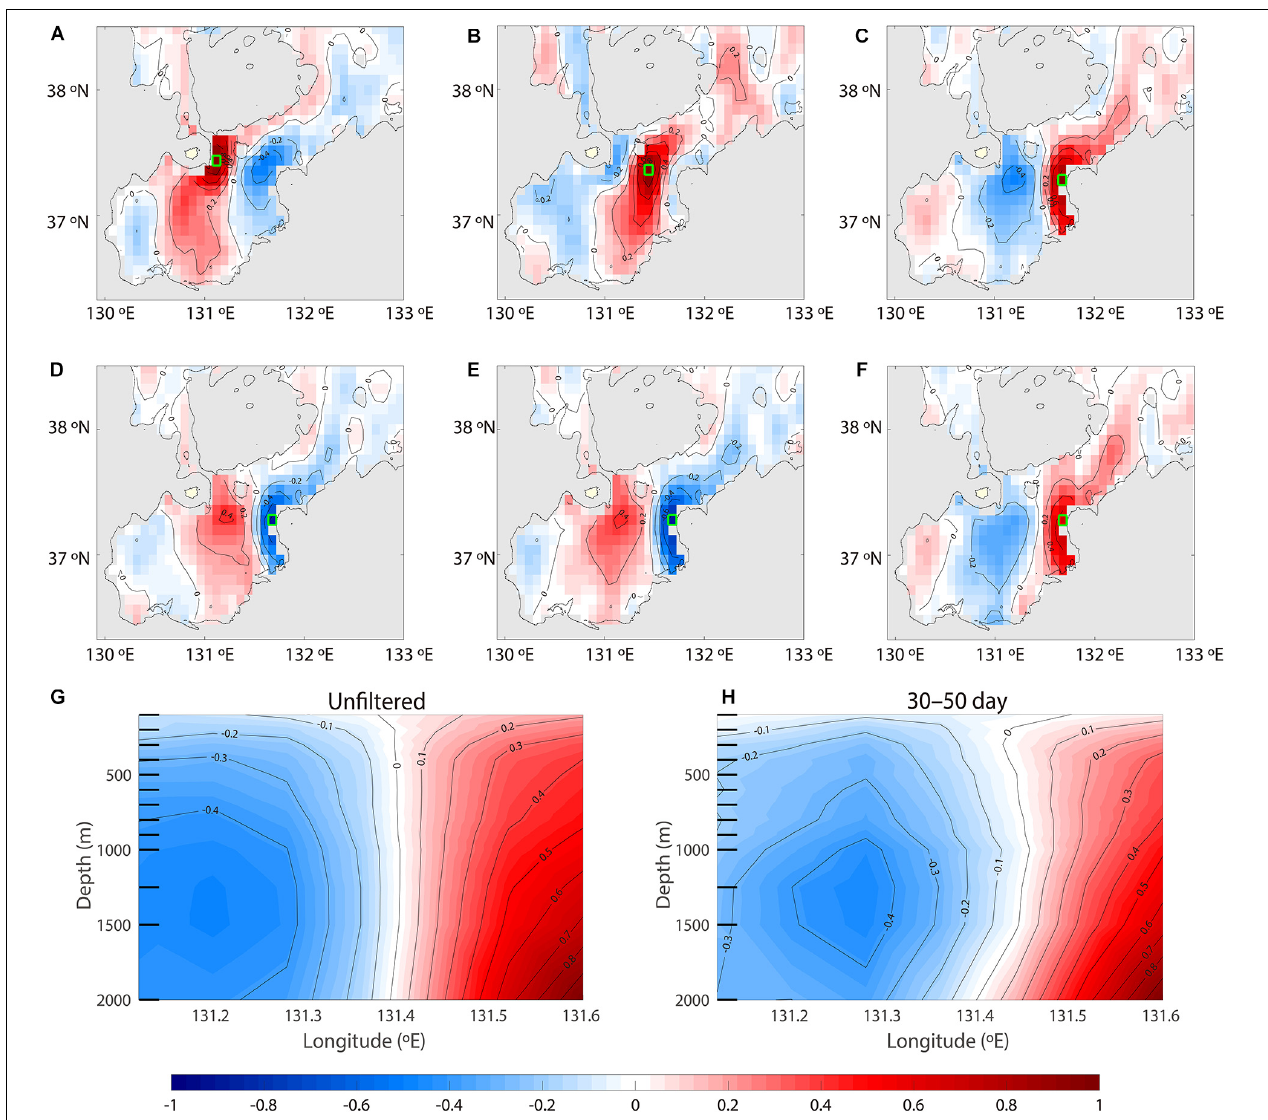
FIGURE 7 | Correlation map, with no lag, of HYCOM deep currents with those in (A) the western UIG, (B) central UIG (nearest to EC1), and (C) eastern UIG (nearest to U5), for the longer intraseasonal band with contours every 0.2 from –1.0 to 1.0. A lagged correlation map in the eastern UIG (D) before 20 days, (E) after 20 days, and (F) after 5 days. Grids of referenced HYCOM currents are marked by green squares. The correlation map, with no lag, of HYCOM meridional currents with those in deep eastern UIG (U5) are shown across the vertical UIG section (G) without and (H) with band-pass filtering (longer intraseasonal band). The HYCOM depth levels are denoted by left axis ticks in panels (G,H)